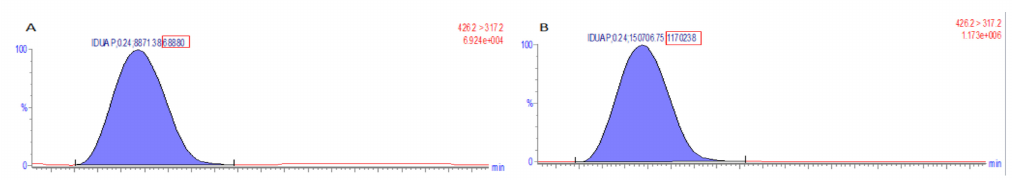
Figure 1. The alpha-iduronidase (IDUA) activities in a selected newborn with low IDUA and a newborn with normal levels of IDUA. ( A ) IDUA product peak area (red box) of 68,880, resulting in a low IDUA of 0.22 nmoL / h / mL; ( B ) IDUA product peak area (red box) of 1,170,238, resulting in an activity of 4.7 nmoL / h / mL in a random newborn sample.